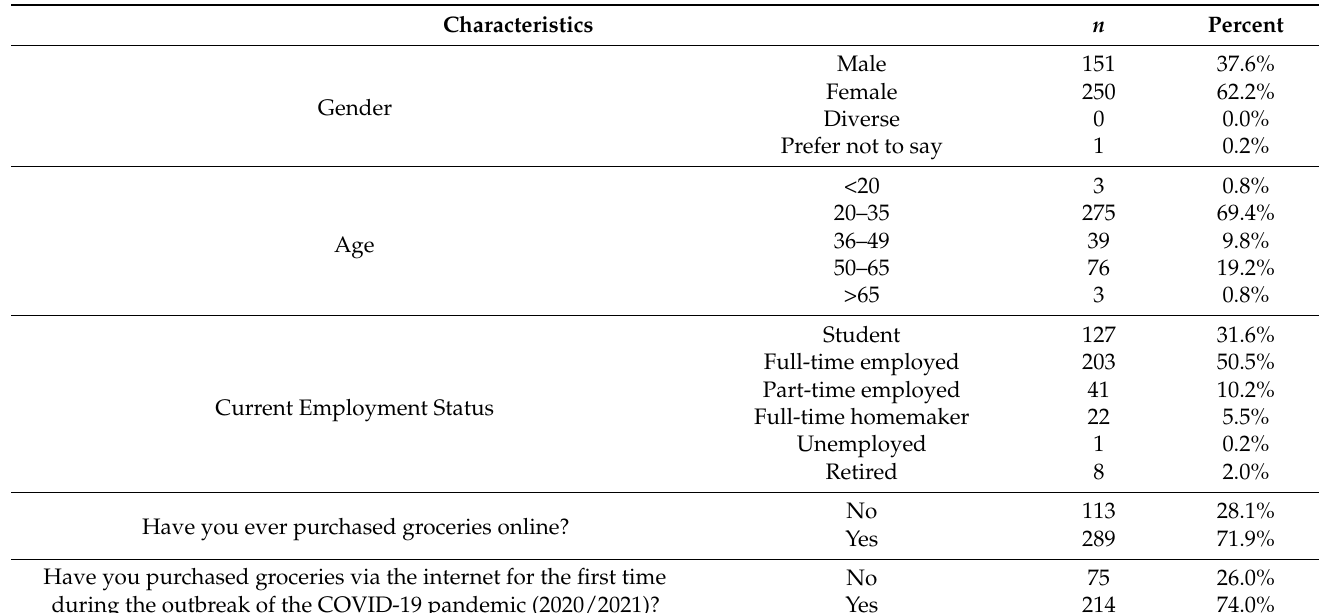
Table 1. Distribution Sample